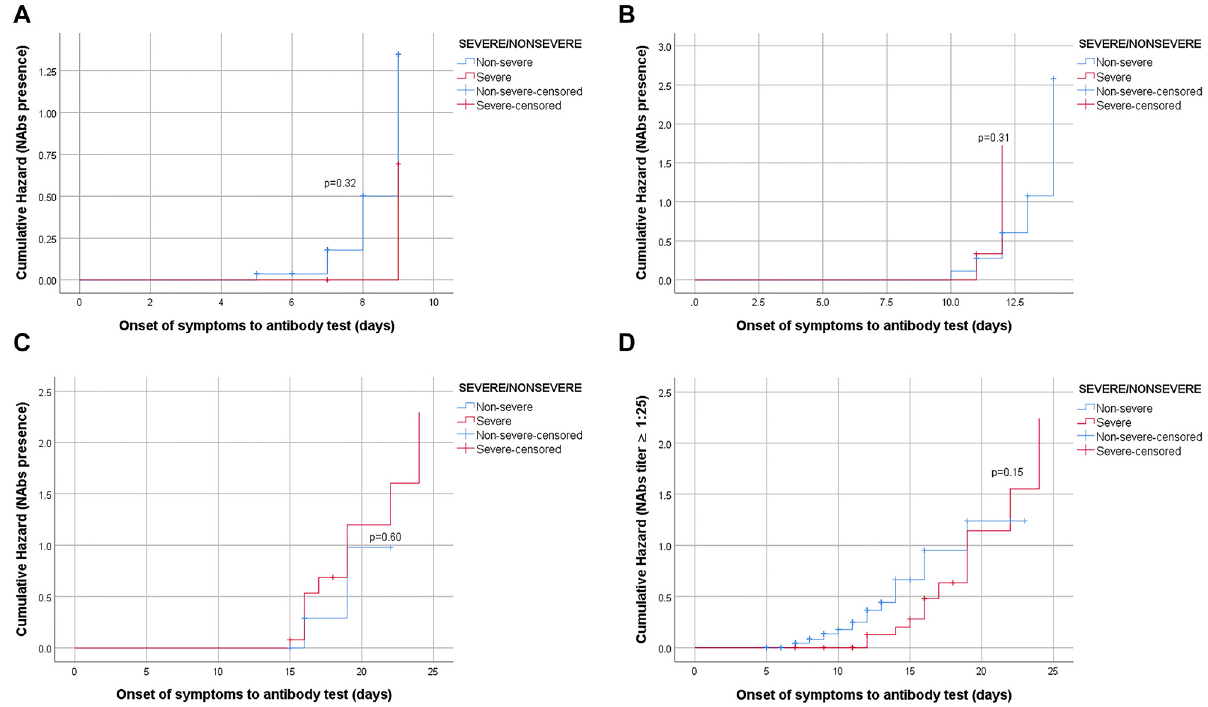
Figure 4: Hazard curves of NAbs by the severity of patients. (A)AssociationbetweenNAbspresenceandseverityofdiseasewasnotstatisticallysignificantlogranktestp-value=0.32(strata1=5 – 9days). (B). Association between NAbs presence and severity of disease was not statistically signi fi cant log rank test p-value=0.31 (strata 2=10 – 14 days). (C). Association between NAbs presence and severity of disease was not statistically signi fi cant log rank test p-value=0.60 (strata 3=14 – 28 days). (D). Association between NAb titer ( ≥ 1:25 vs. <1:25) and severity of disease was not statistically signi fi cant log rank test